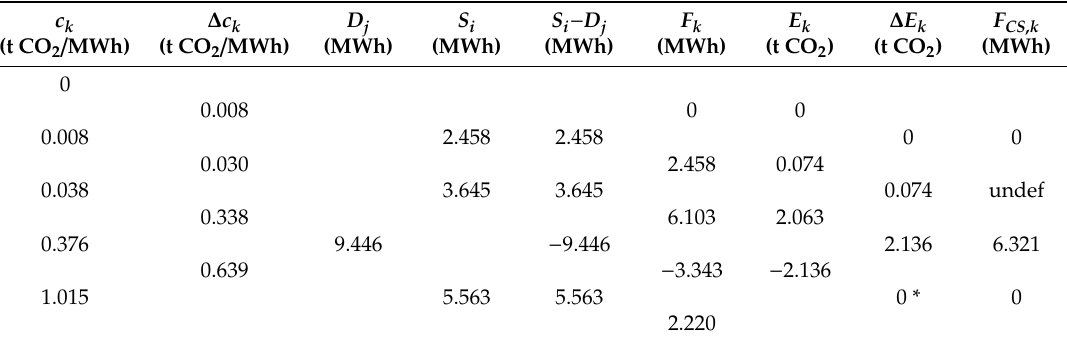
Table 6. Minimum low-carbon energy solution applying cascade